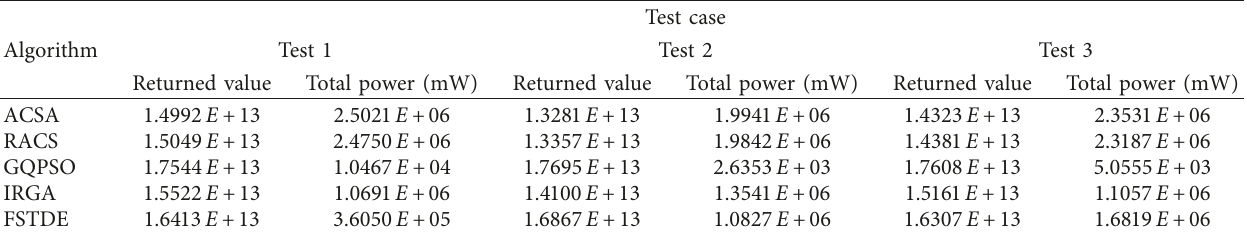
Table 20: Returned values and total power of ACSA and other advanced optimization algorithms in scenario 3 in three more test cases.